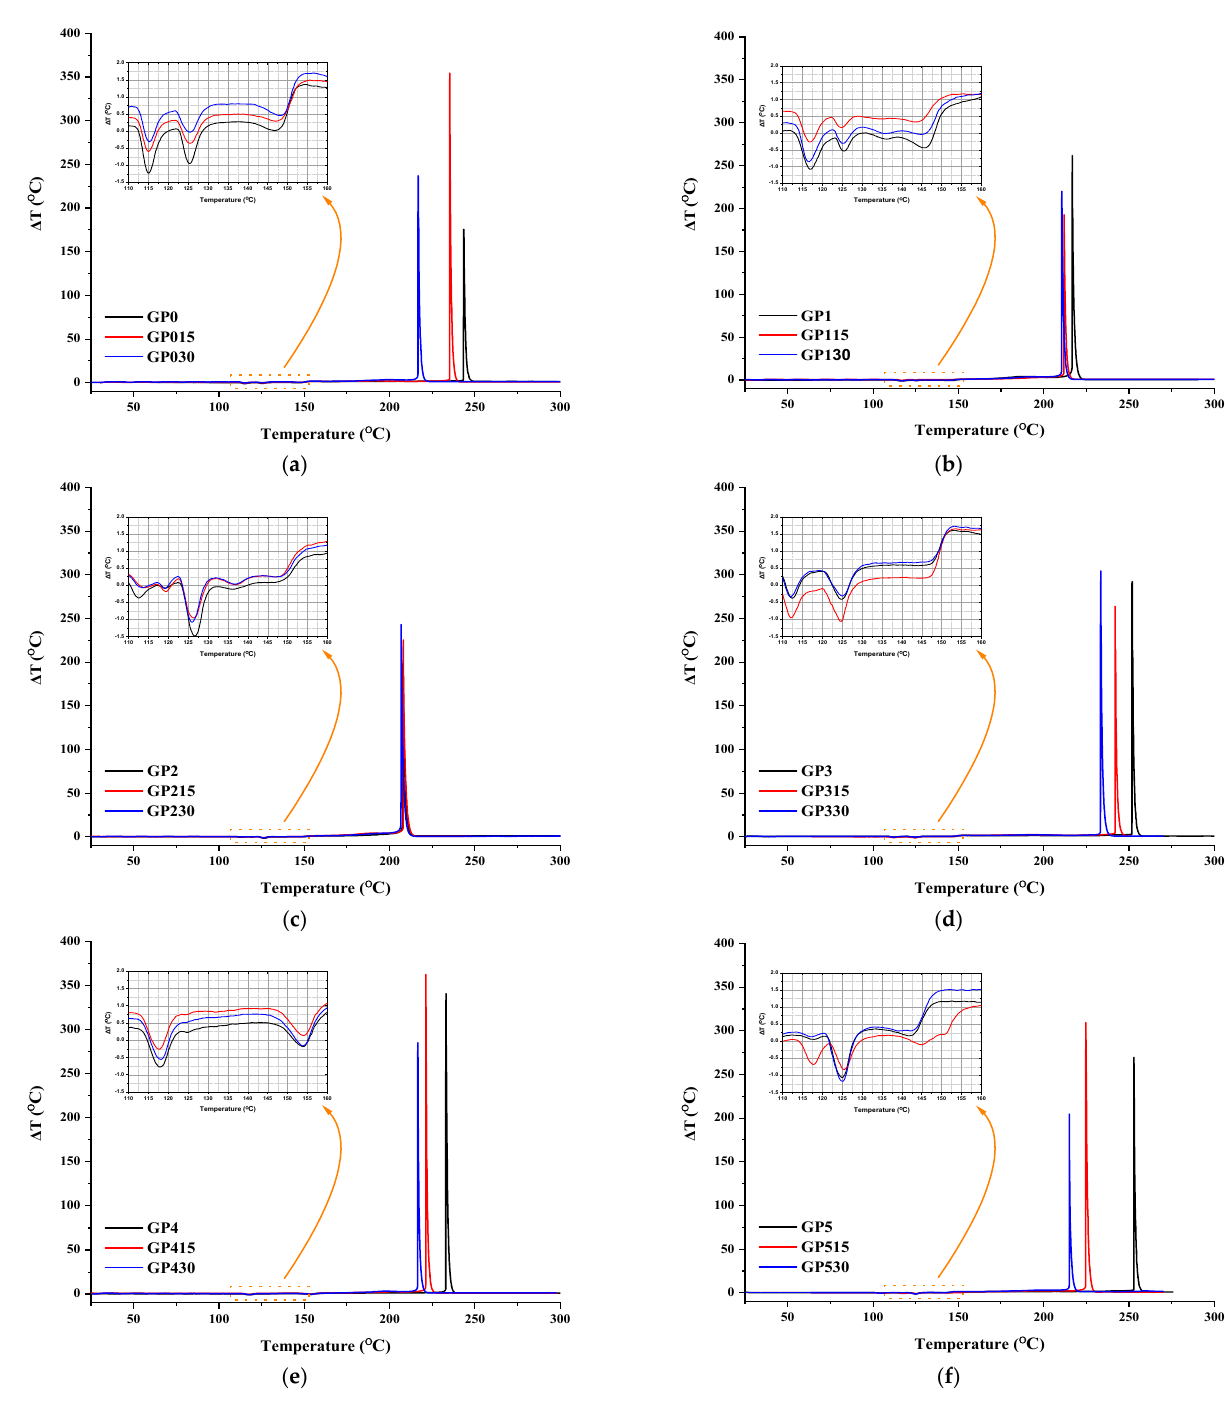
Figure 12. DTA thermograms of “greener” composite rocket propellants. ( a ) PSAN _0; ( b ) PSAN_1; ( c ) PSAN_3; ( d ) PSAN_4; ( e ) PSAN_5; ( f ) PSAN_6). Table 7. Thermal characteristics of “green” considered fuel formulations.